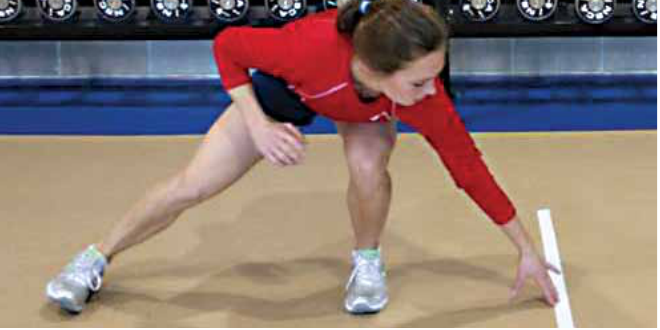
Figure 5-38. Touching the Line with the Outside